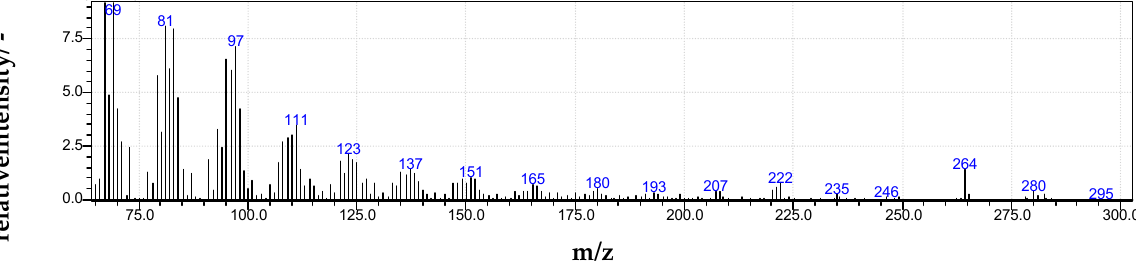
Figure 8. Mass spectrum of the final unidentified peak fragment on the chromatogram of P.tremula extract with a retention time of 26.82.